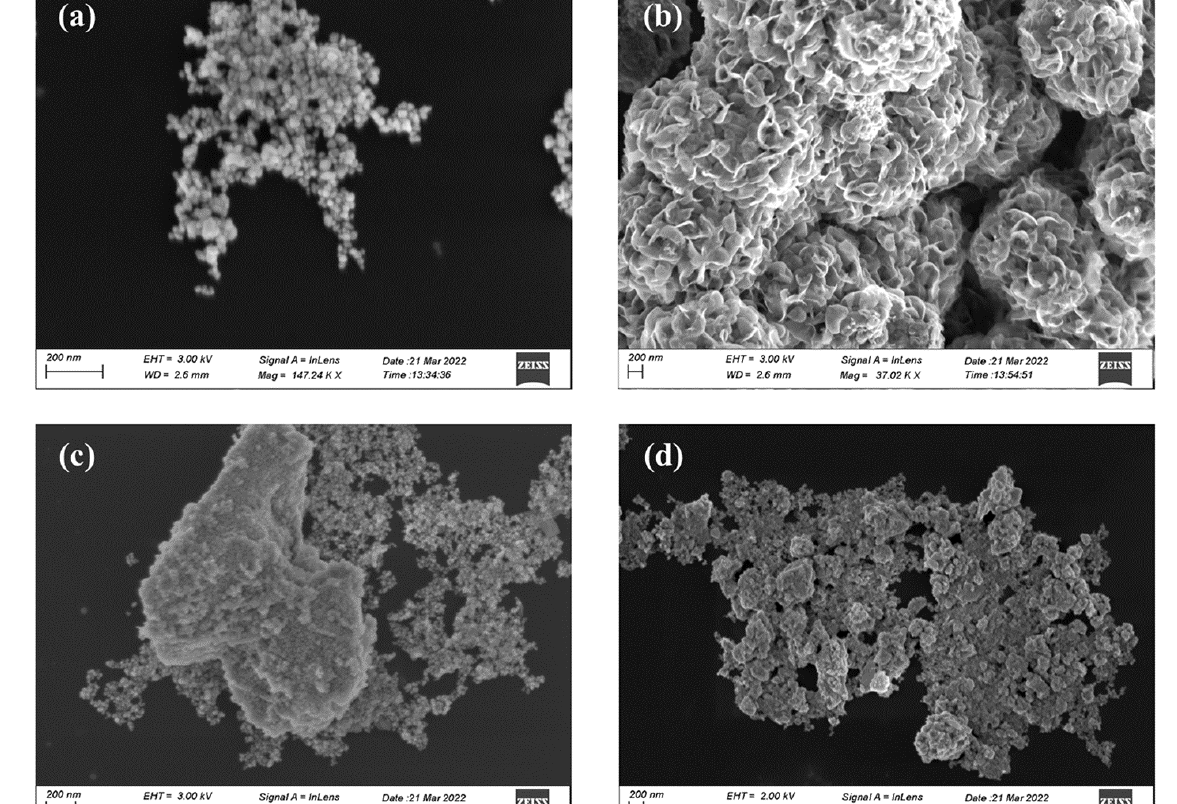
Figure 2. FESEM images of ( a ) N, ( b ) M, ( c ) NM3, and ( d ) NM10.